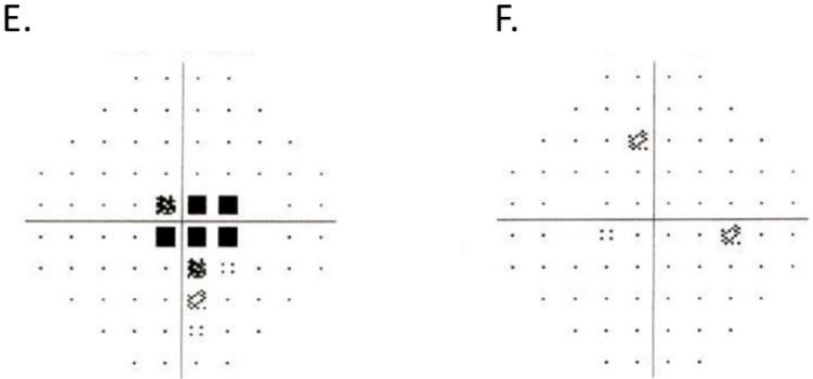
Figure 1. ( A , B ) color fundus photographs of the right eye ( A ) and left eye ( B ) 8 days after receiving the second COVID-19 vaccination. ( C , D ) fluorescein angiography findings in the right eye ( C ) and left eye ( D ) at the late stage. ( E , F ) Humphrey’s visual field analysis of the right eye ( E ) and left eye ( F ).